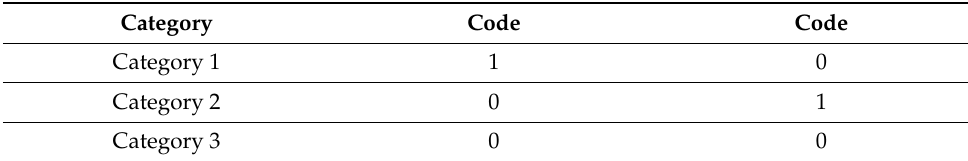
Table 1. Coding of dummy